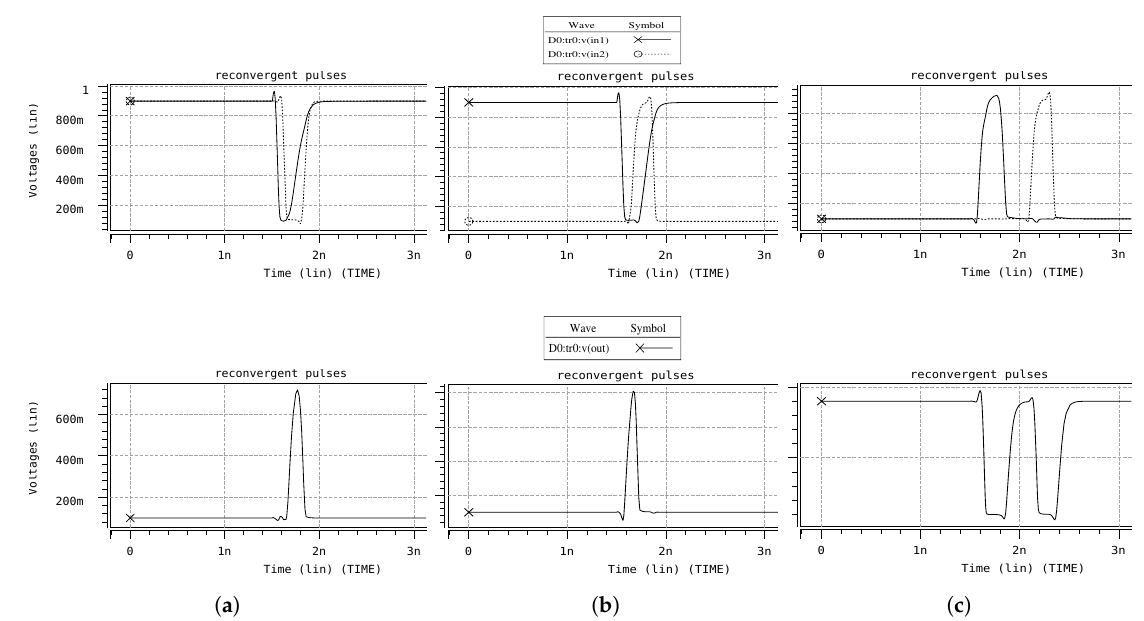
Figure 5. Output pulses for ( a ) same direction, ( b ) different direction and ( c ) non-overlapping input reconvergent